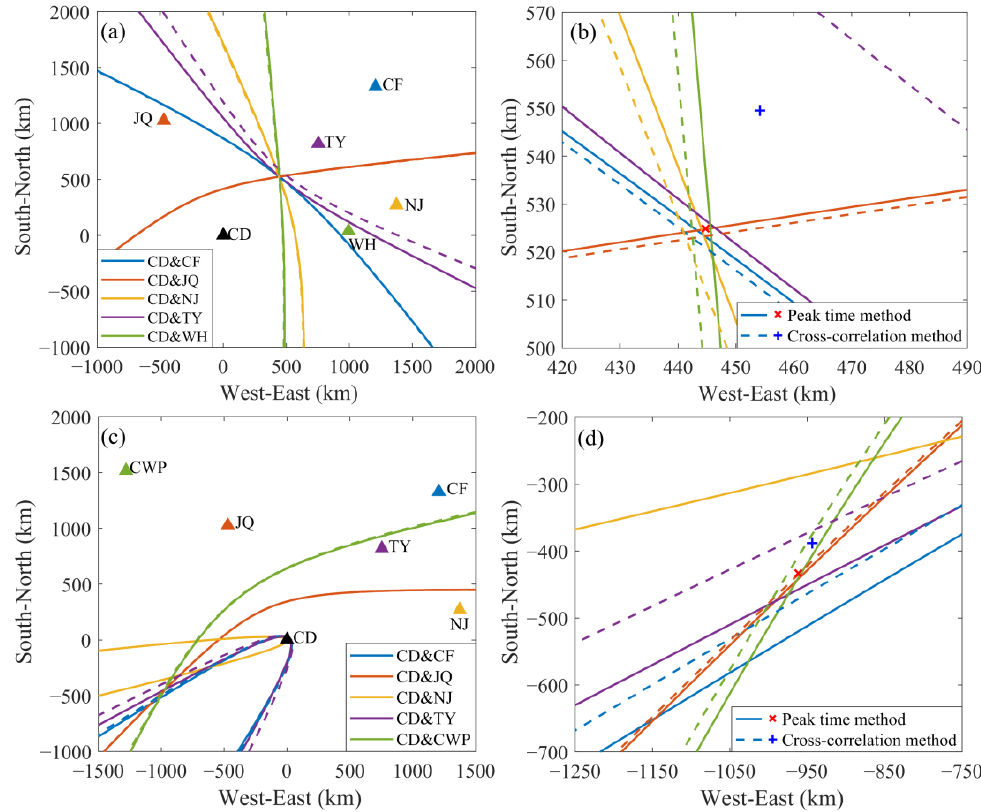
Figure 3. The horizontal projection of the hyperbolic map for the peak time method (solid line) and cross-correlation method (dashed lines). ( a ) Locating a source inside the network. Five hyperbolas of the different colors that are the same as in Figure 1 are shown corresponding to the following sensor pairs: CD – CF, CD – JQ, CD – NJ, CD – TY and CD – WH. ( b ) The partial enlargement of ( a ) and the optimum locations sought by the peak time method (“ × ” in red) and cross-correlation method (“+” in blue). ( c ) Locating a source outside the network. Five hyperbolas of the different colors that are the same as in Figure 2 are shown corresponding to the following sensor pairs: CD – CF, CD – JQ, CD–NJ, CD–TY and CD–CWP. ( d ) The partial enlargement of ( c ) and the optimum locations